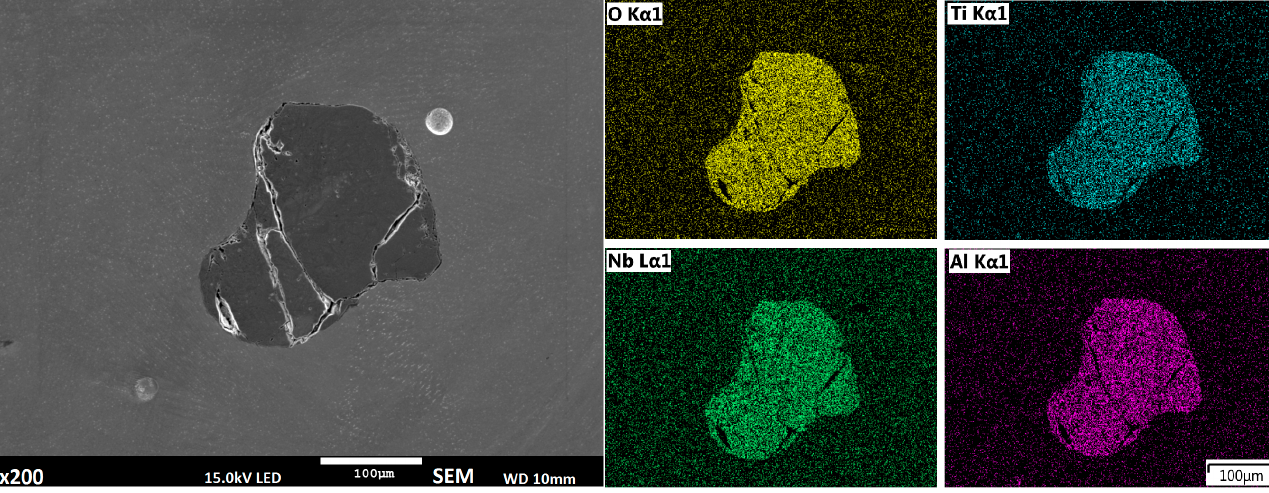
Figure 6. Inclusion inside the buffer zone, deposited using laser melting of metal powder. Deposition of metal powder alone provided good properties with restriction of chemical components from the substrate; however, the deposition mechanism can lead to discontinuities in the material due to disturbances in the solidification process (Figure 7).